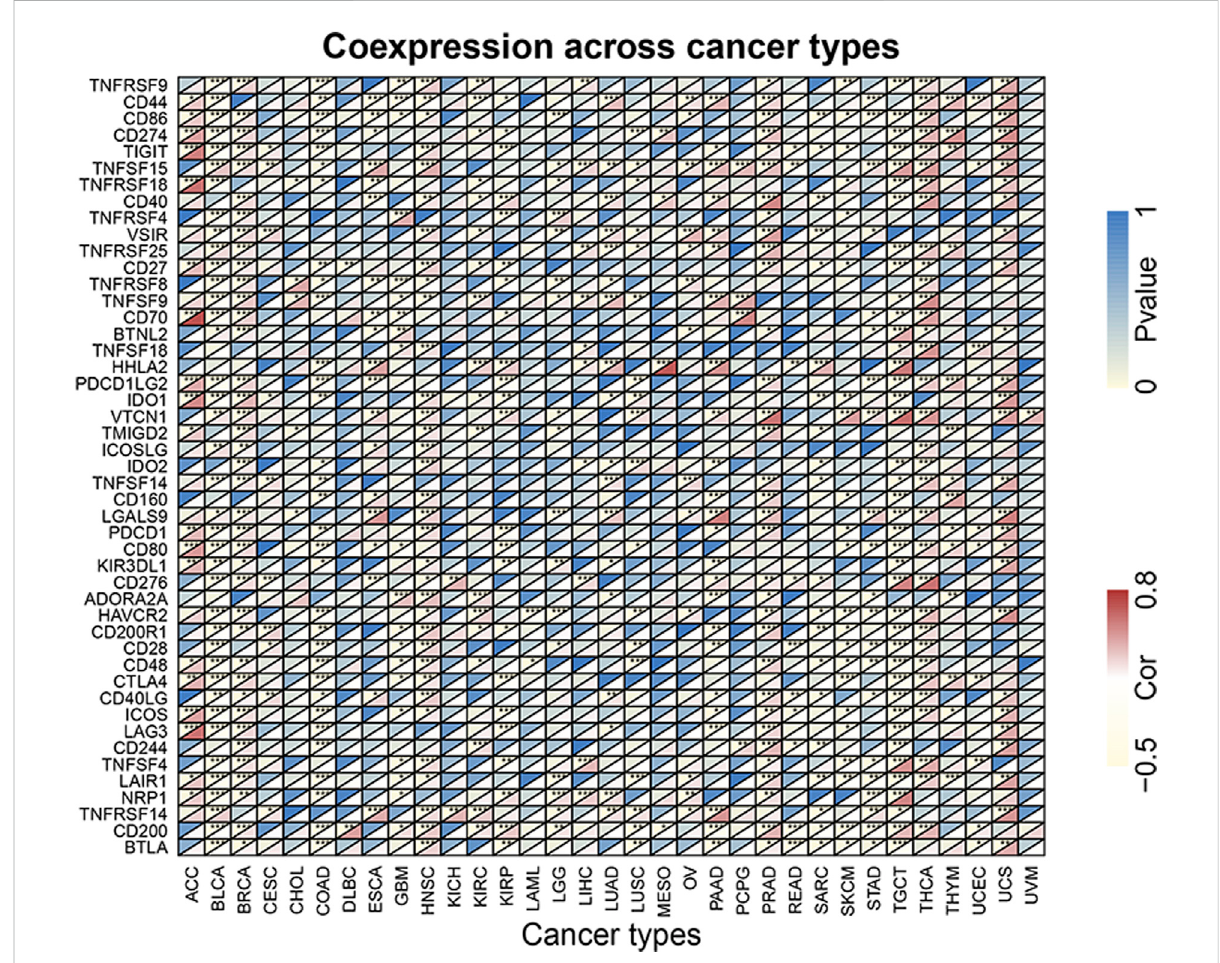
FIGURE 11 Coexpressionofforkheadbox Q1with immune-related genesinpan-cancer. The red colorrepresents thecorrelationcoef fi cient, and theblue color represents the p value. * p < 0.05, ** p < 0.01, and *** p <